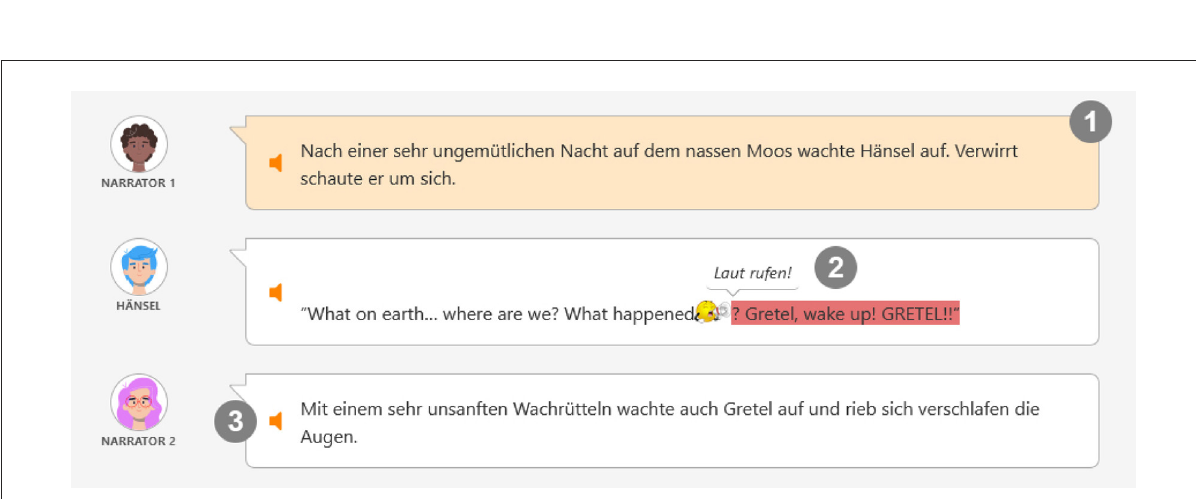
FIGURE5 (1) The GameLet UI highlights the role assigned to a student to facilitate orientation. (2) Students can also comment on the various kinds of moods and forms of speaking that are a part of their texts. (3) They can listen to audio models of their own and others’ roles when clicking on the loudspeaker